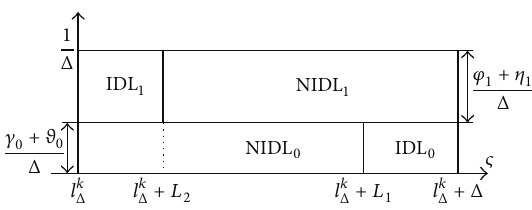
Figure 2: Scheme of labeling and distribution of original samples prior to